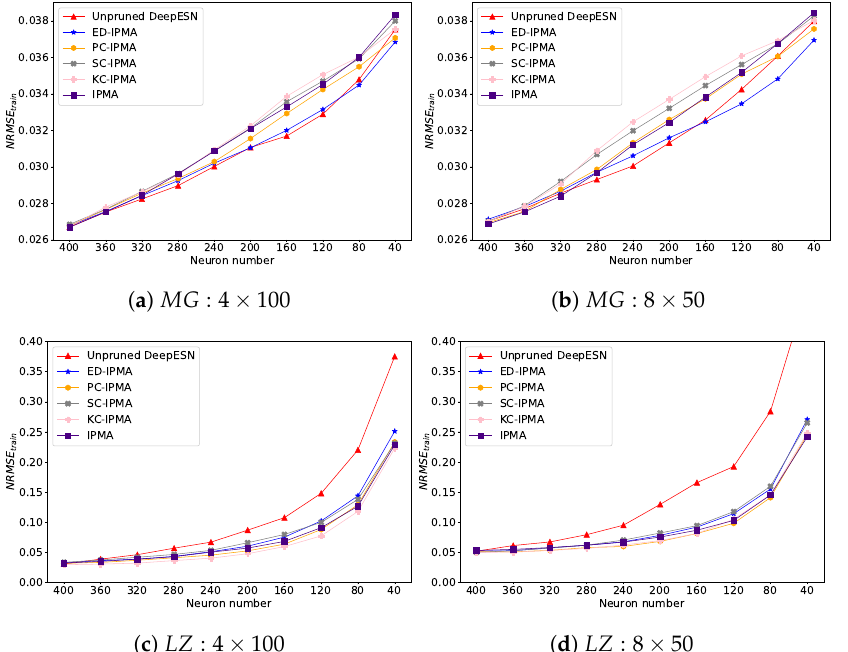
Figure 9. Training NRMSE comparison of unpruned DeepESN and DeepESN pruned by IPMA, ED-IPMA, PC-IPMA, SC-IPMA, KC-IPMA. ( a ): Initial 4 layer reservoirs with 100 neurons in each reservoir on MG dataset; ( b ): Initial 8 layer reservoirs with 50 neurons in each reservoir on MG dataset; ( c ): Initial 4 layer reservoirs with 100 neurons in each reservoir on LZ dataset; ( d ): Initial 8 layer reservoirs with 50 neurons in each reservoir on LZ